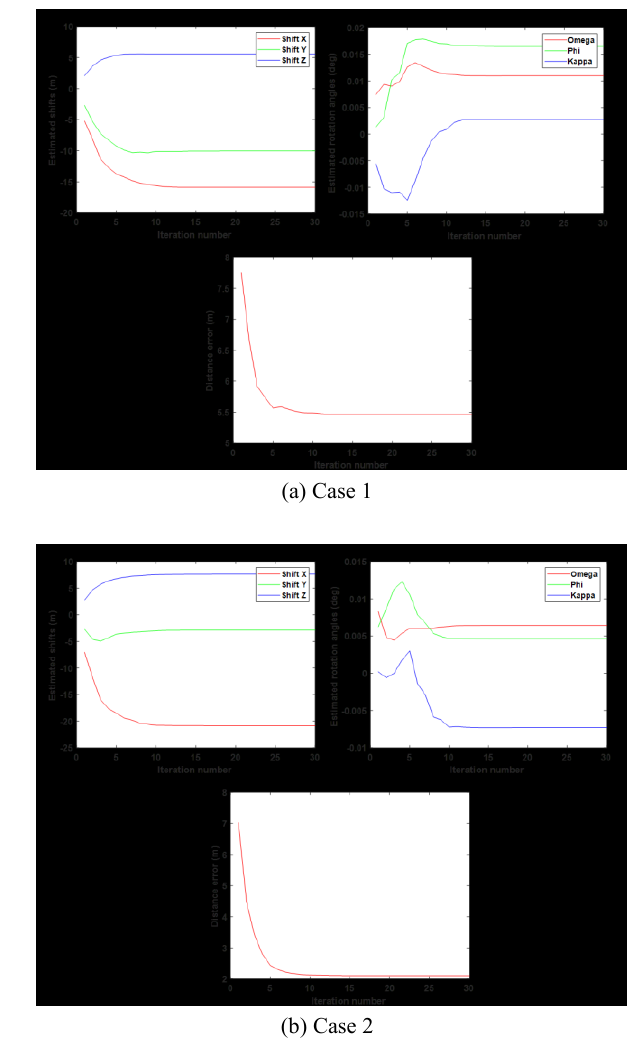
Figure 8. Convergence behaviour of the matching algorithm Table 1 lists the estimated parameters of point-to-surface matching for both cases. For the estimated shifts and rotation angles there are much smaller standard deviations in Case 1 than in Case 2, which is due to the different number of points.